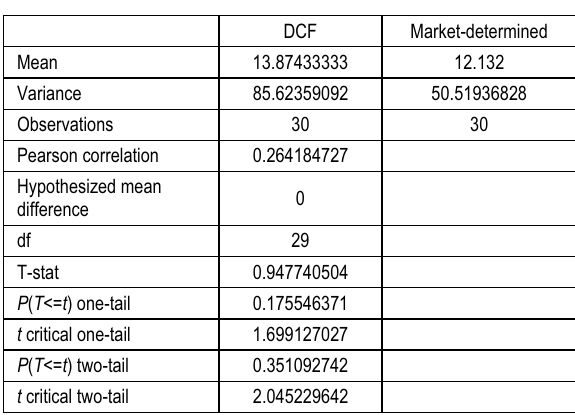
Table 1. T-test: paired two sample for means for EV/EBITDA DCF Market-determined Mean 13.87433333 12.132 Variance 85.62359092